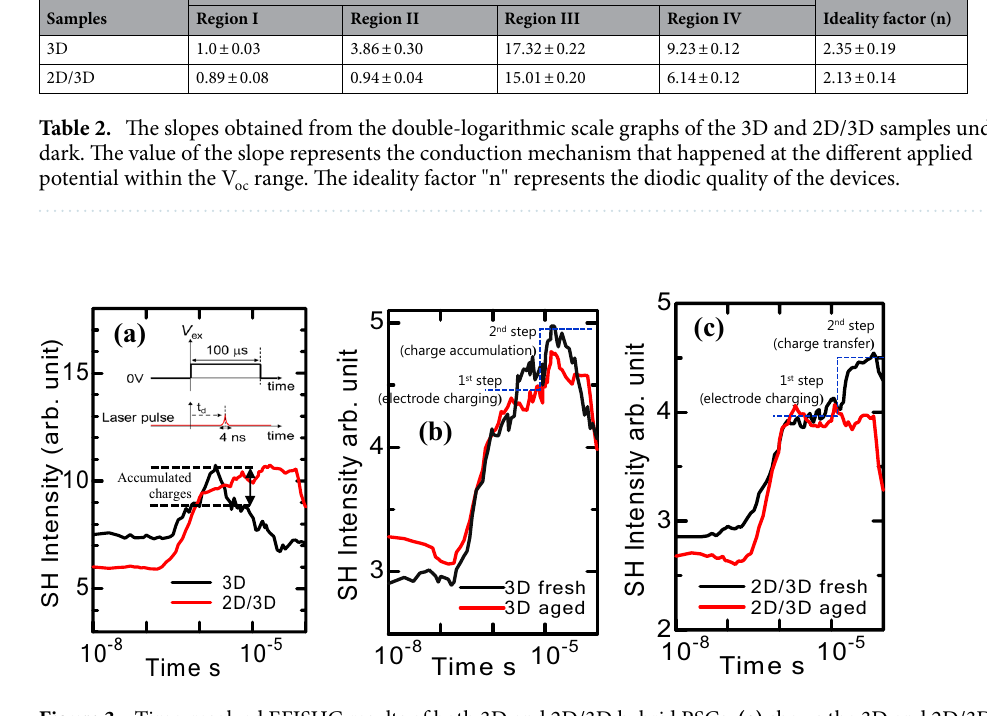
Figure 3. Time-resolved EFISHG results of both 3D and 2D/3D hybrid PSCs. (a) shows the 3D and 2D/3D hybrid samples; the dotted lines’ difference presents the charge accumulation in the 3D sample. (b,c) illustrates the time-resolved EFISHG measurements of the fresh and aged 3D and 2D/3D hybrid samples. AC square wave (− 3 V) with a pulse width of 100 µs was applied to the Au electrode with reference to